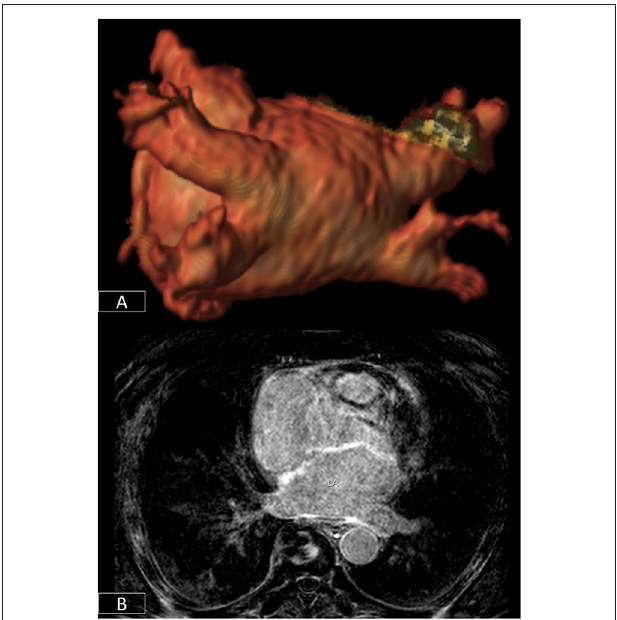
FIGURE 6 | 3D-segmentation of the left atrium depicting left atrial anatomy and four pulmonary veins and their tributaries (A) . There is extensive fibrosis of the left atrial wall (B) on 3D late enhancement sequences which may reduce the likelihood of successful ablation.